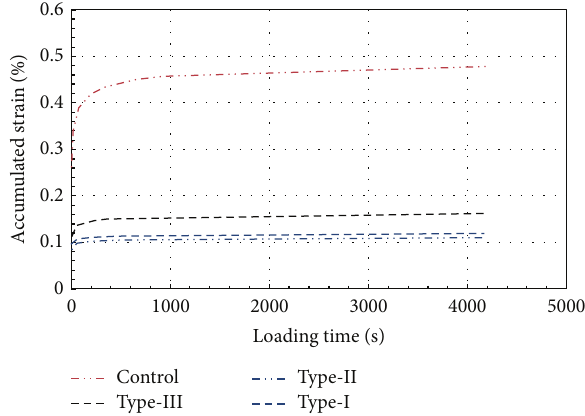
Figure 7: Variation of accumulated strain with respect to rubber type and time.